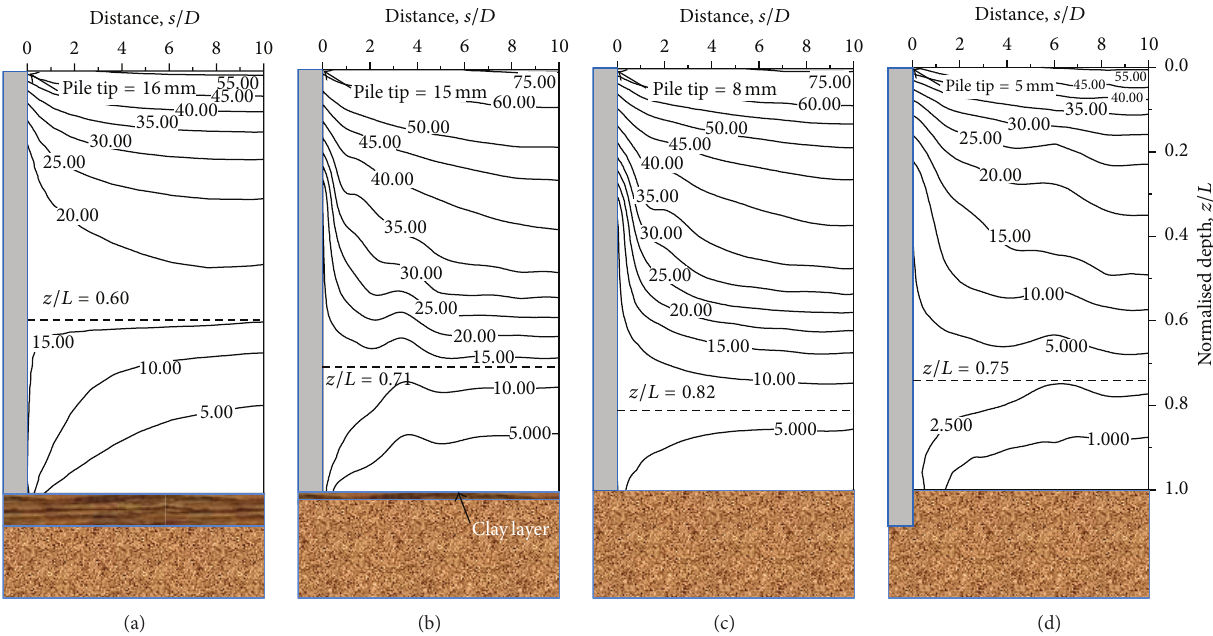
Figure 6: Settlement contour of the soil surrounding a pile with tip location: (a) 𝑌 = 1.00𝐷 , (b) 𝑌 = 0.25𝐷 , (c) 𝑌 = 0.00𝐷 , and (d) 𝑌 = −1.00𝐷 .